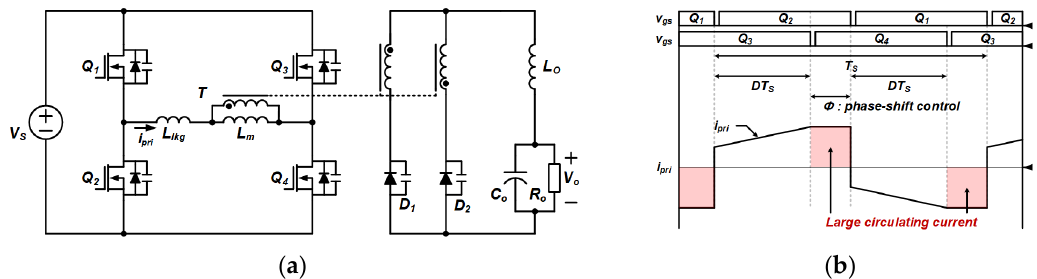
Figure 1. Conventional phase-shifted full-bridge (PSFB) converter. ( a ) Circuit diagram. ( b ) Primary current waveform.